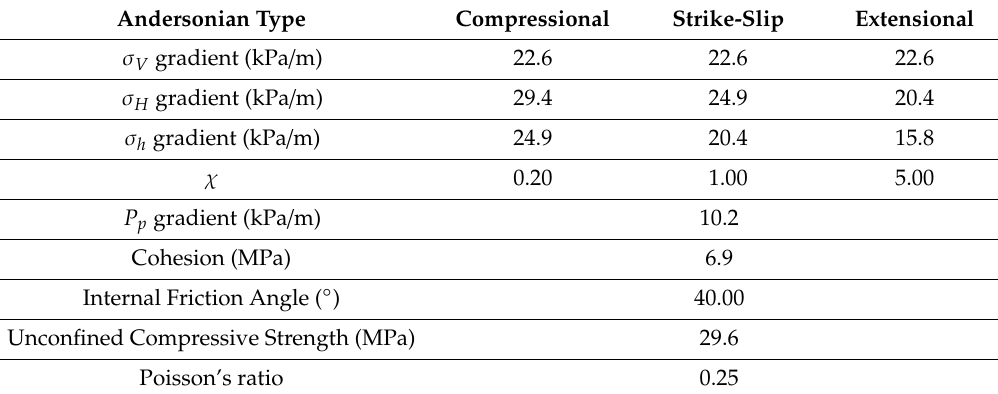
Table 2. Input data for the three Andersonian